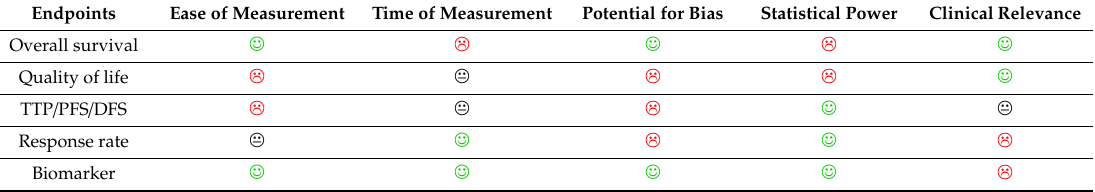
Table 4. Conceptual representation of the advantages and disadvantages of endpoints commonly used in